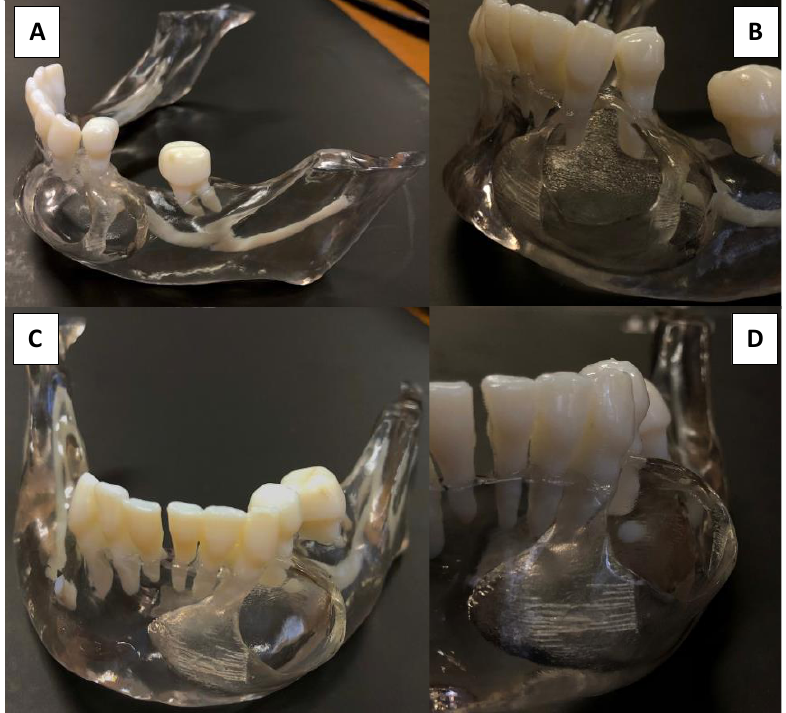
Figure 5. 3D printed stereolithographic model. ( A ) Lateral model view. ( B ) Close image of lesion representation showing anterior and posterior cortical discontinuity. ( C ) Frontal view showing frontal cortical perforation. ( D ) Frontal view of the lesion showing mandibular nerve passage inside it.